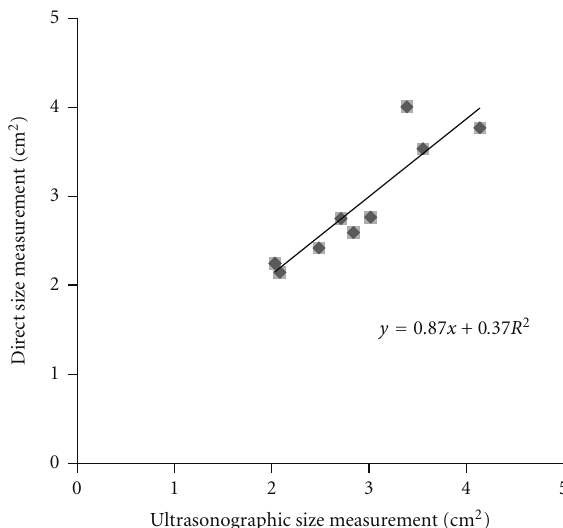
Figure 3: Correlation between ultrasonographic and direct (macro- scopic) measurements of tumor size. Pearson’s correlation coe ffi - cient ( R 2 ) between the ultrasonographic and the direct measure- ments was found to be 0.84 ( n = 10, P < 0 . 001).